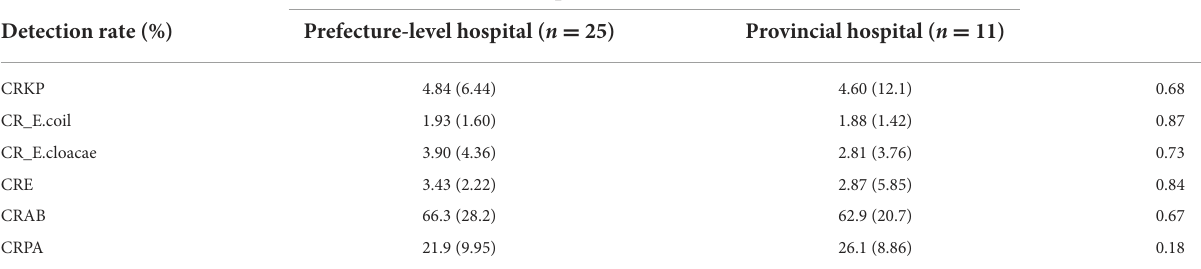
Hospitals rank median